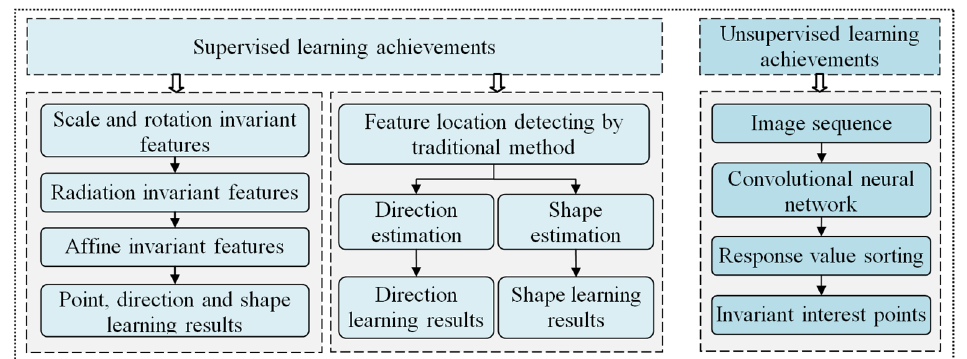
Figure 2. Development of feature detection with deep learning.